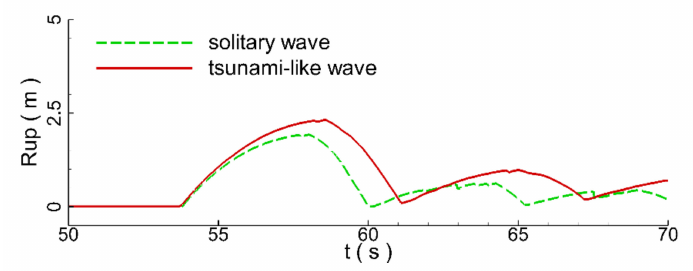
Figure 16. Comparison of the time series of wave runup